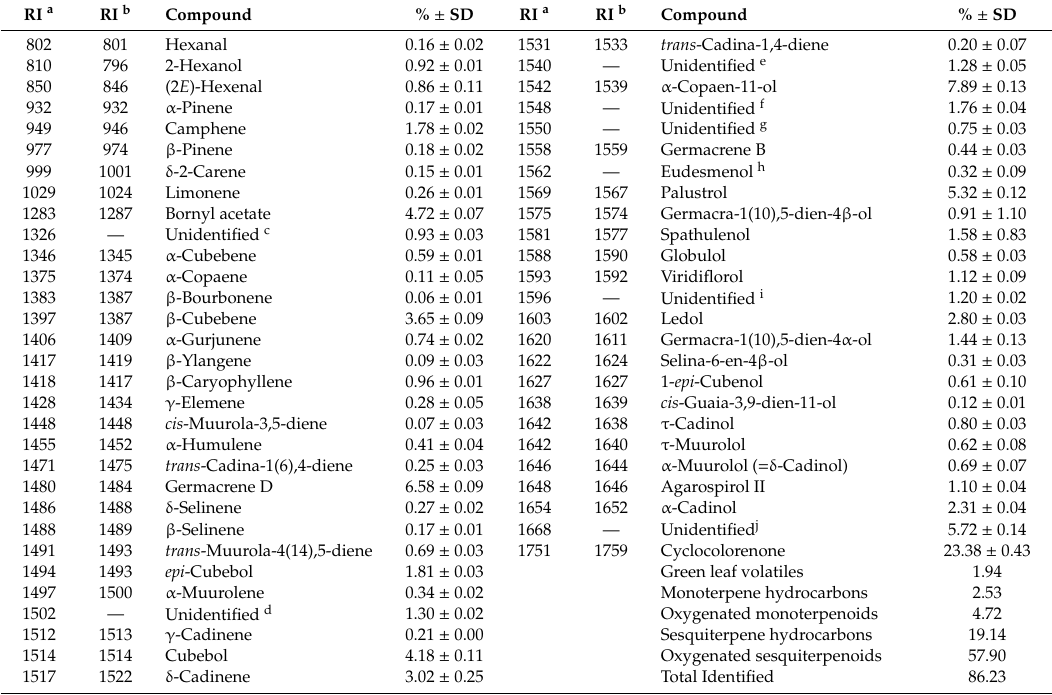
Table 1. Chemical composition of the essential oil of Eupatorium serotinum